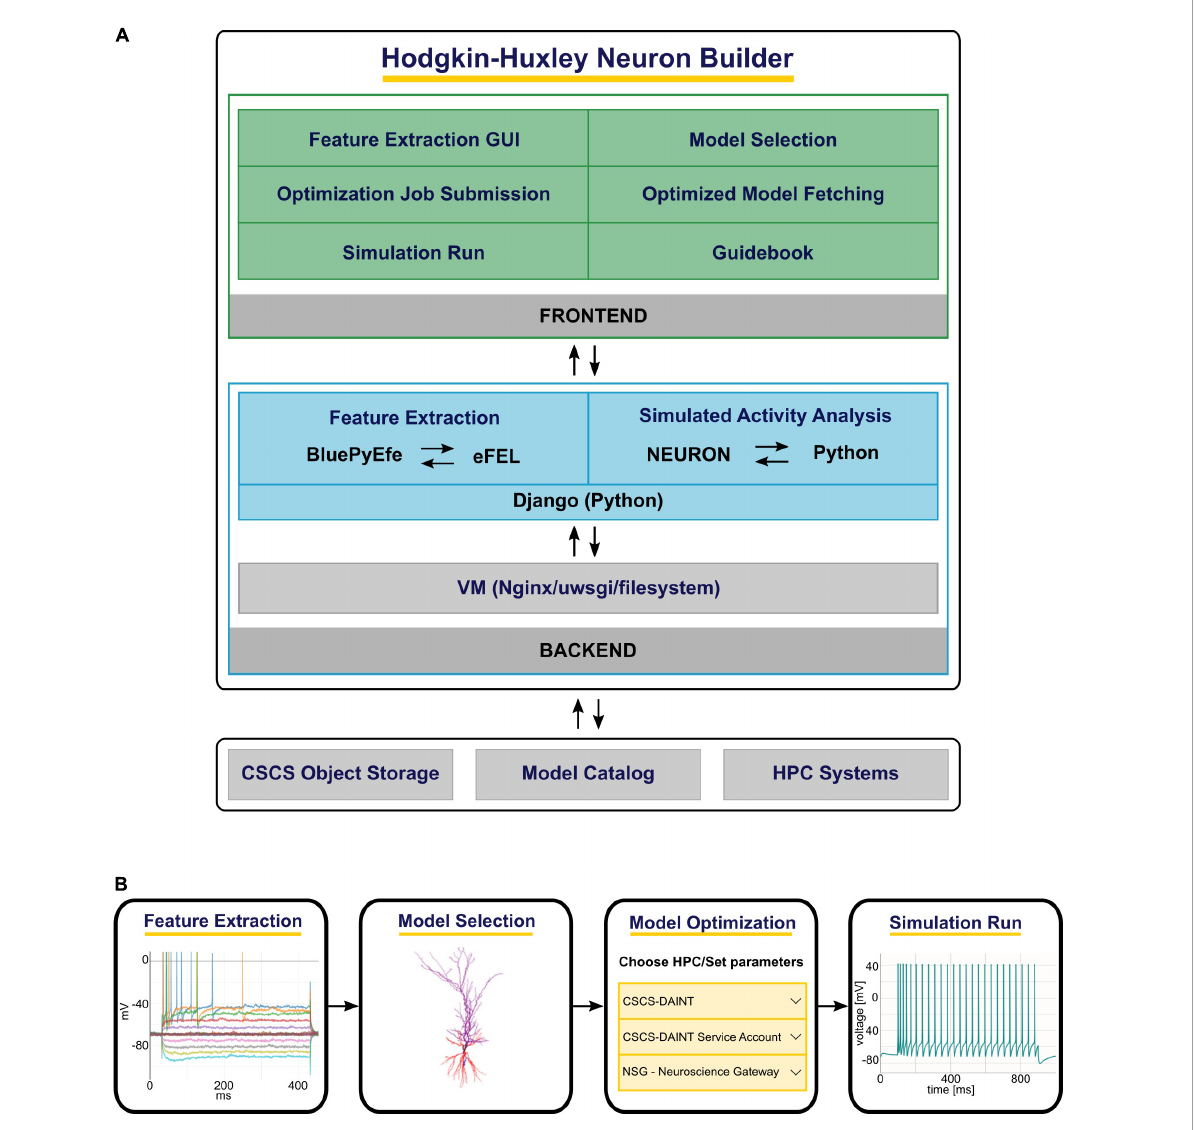
FIGURE1 The Hodgkin-Huxley Neuron Builder (HHNB) architecture and workflow. (A) From top to bottom: The HHNB frontend allows to interact with the web application in order to extract electrophysiological features from recorded or simulated data, choose a model from the EBRAINS Model Catalog or upload the model’s components, submit the optimization job to an HPC system, fetch the optimized model and run the simulation. The HHNB backend performs the feature extraction, the optimized model analysis and all the data management operations (e.g., files and folders creation, data upload/download). The interaction with the external platforms is guaranteed via direct access (CSCS Object Storage and Model Catalog) or dedicated APIs (HPC Systems). (B) The various steps involved in the HHNB workflow. Users are offered flexibility to